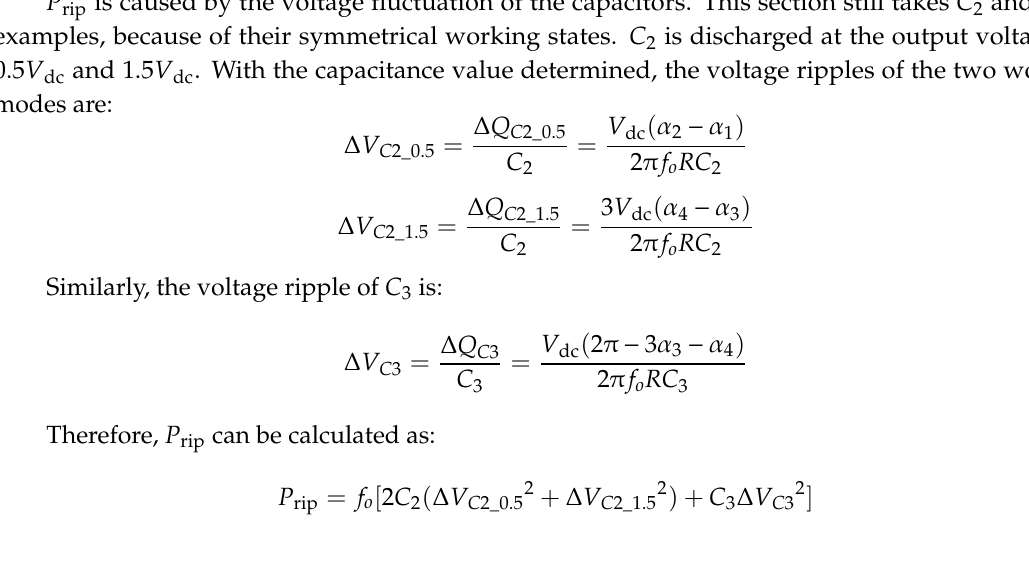
( d ) Figure 9. Equivalent circuits of four working modes. ( a ) +0.5 V dc , ( b ) + V dc , ( c ) +1.5 V dc , ( d ) +2 V dc . The parameters of each component are as follows: V D and R D are the voltage drop and on-state resistance of the diode, ESR C and r S are the equivalent resistance of the capacitor and the switch, R is the load, and i o is the output current. The equivalent parameters of the components in the four